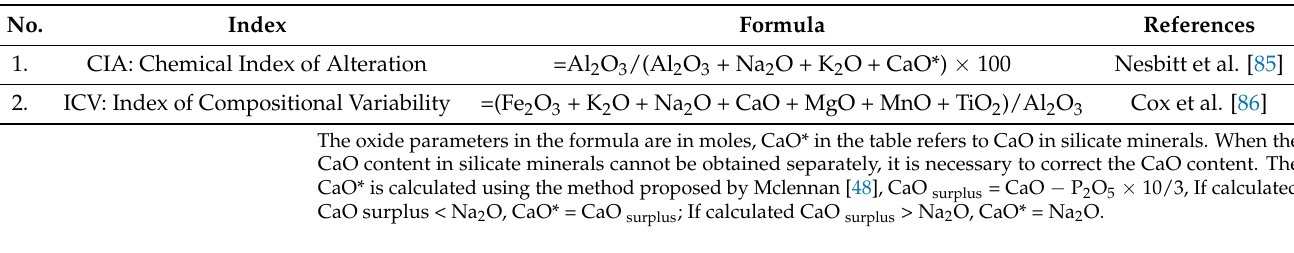
Table 1. Summary of chemical weathering indices and their computational